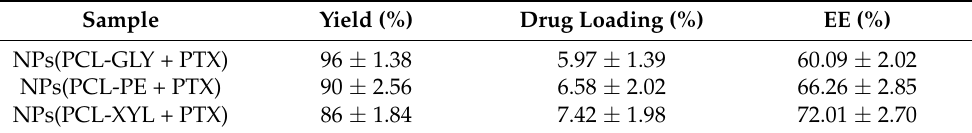
Table 2. NPs’ yield, drug loading, and encapsulation efficiency (EE). Sample Yield (%) Drug Loading (%) EE (%) NPs(PCL-GLY +